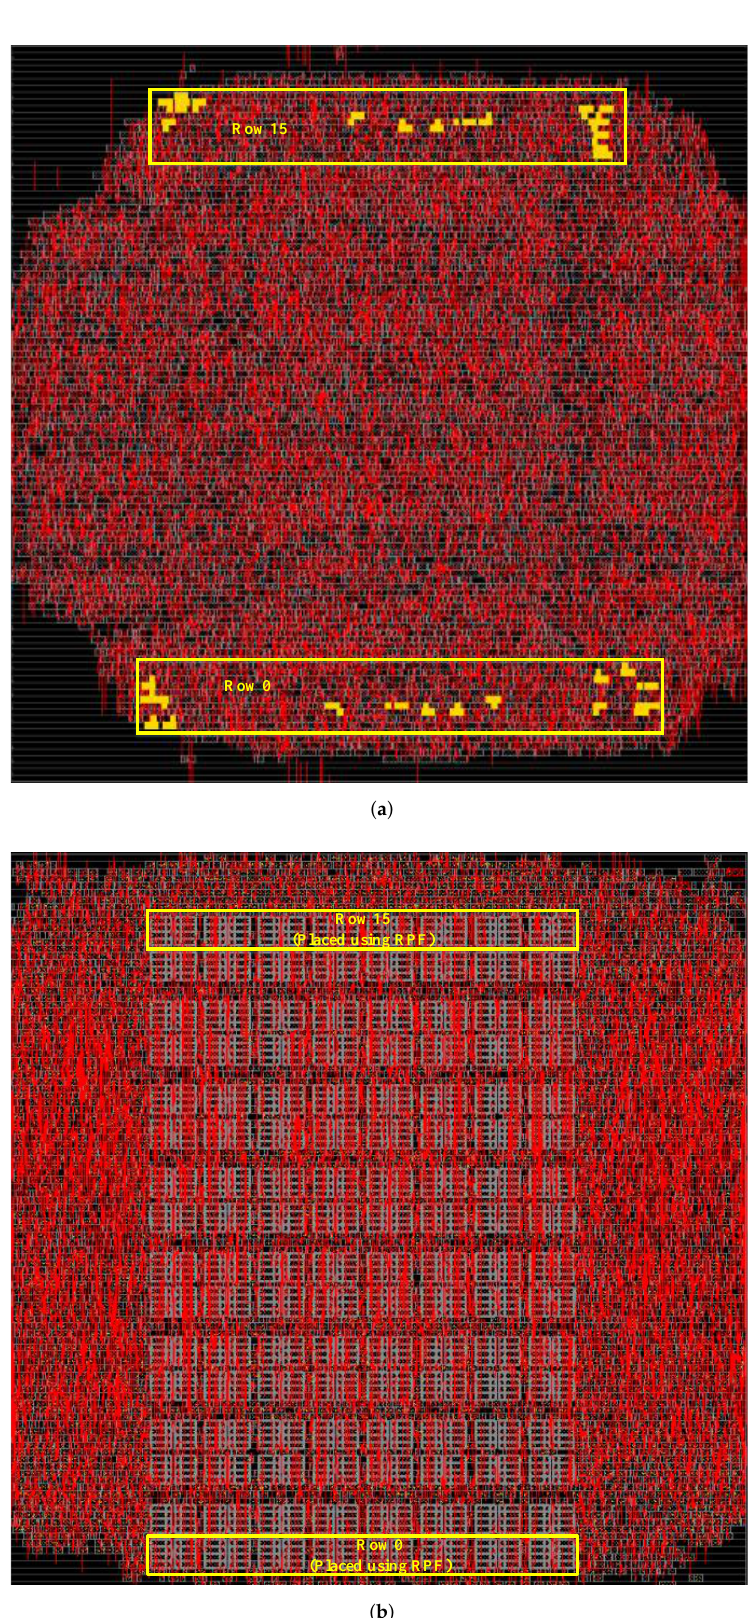
Figure 7. Layout of RFile in both Normal and SDP Flow. ( a ) Layout of RFile in the Normal Flow. ( b ) Layout of RFile in the SDP